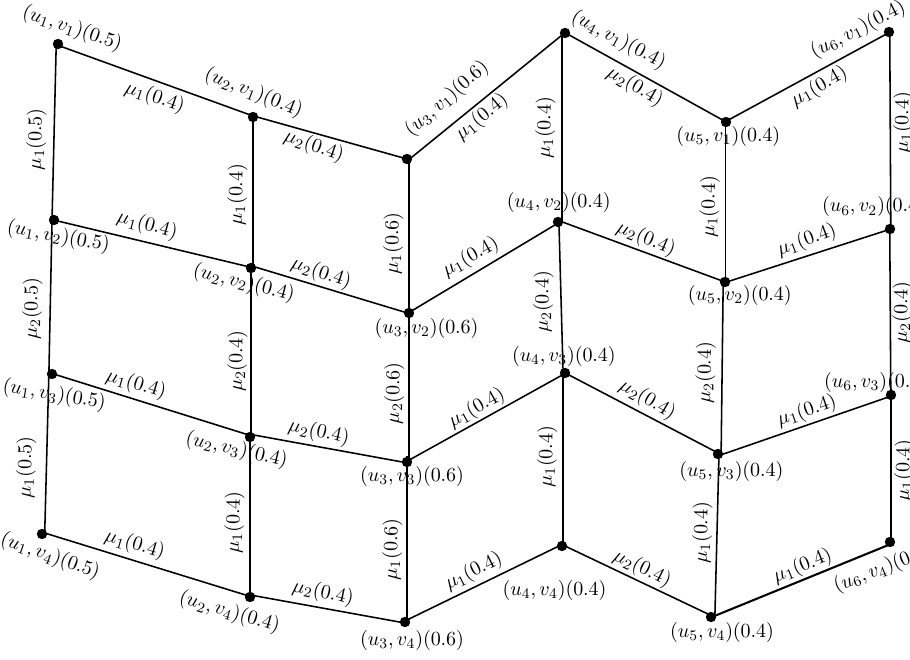
Figure 14. Maximal Product of G 1 and G 2 Figure 14: Maximal Product of G 1 and G 2